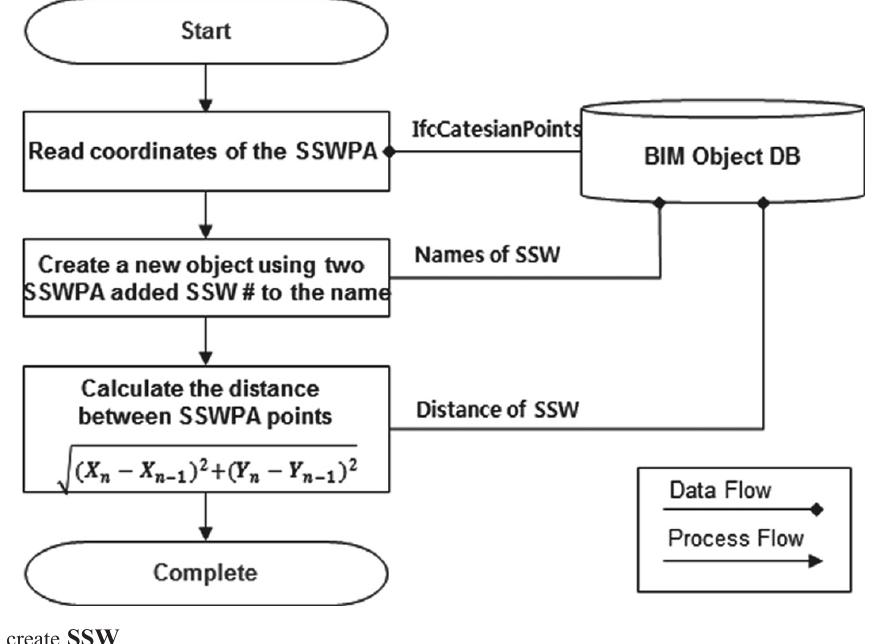
Fig. 8. Process to create SSW n Table 1. Data mapping to generate INP file Required data for INP file